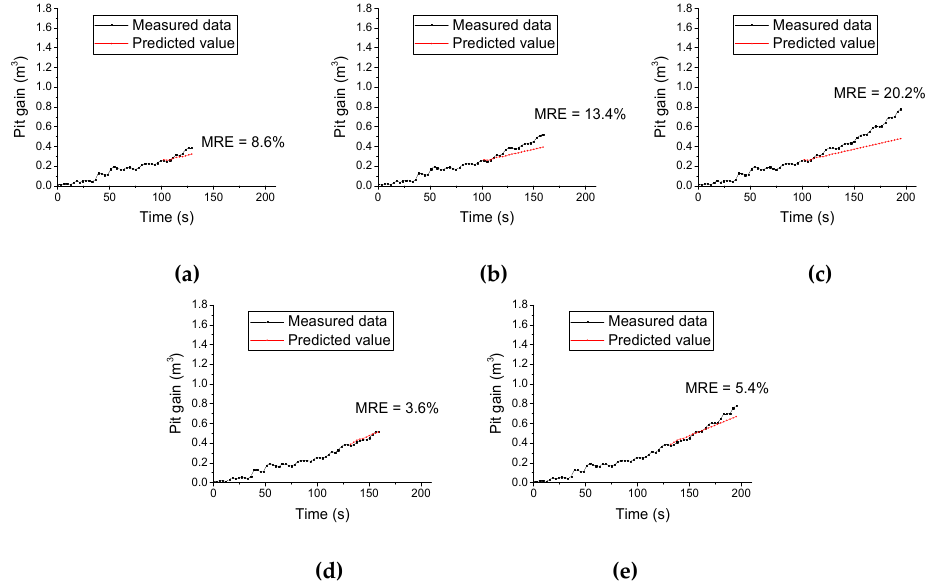
Figure 12. Measured data and predicted values of the pit gain vs. time in different periods: ( a ) prediction period 99–129 s, ( b ) prediction period 99–159 s, ( c ) prediction period 99–195 s, ( d ) prediction period 129–159 s, and ( e ) prediction period 129–195 s.